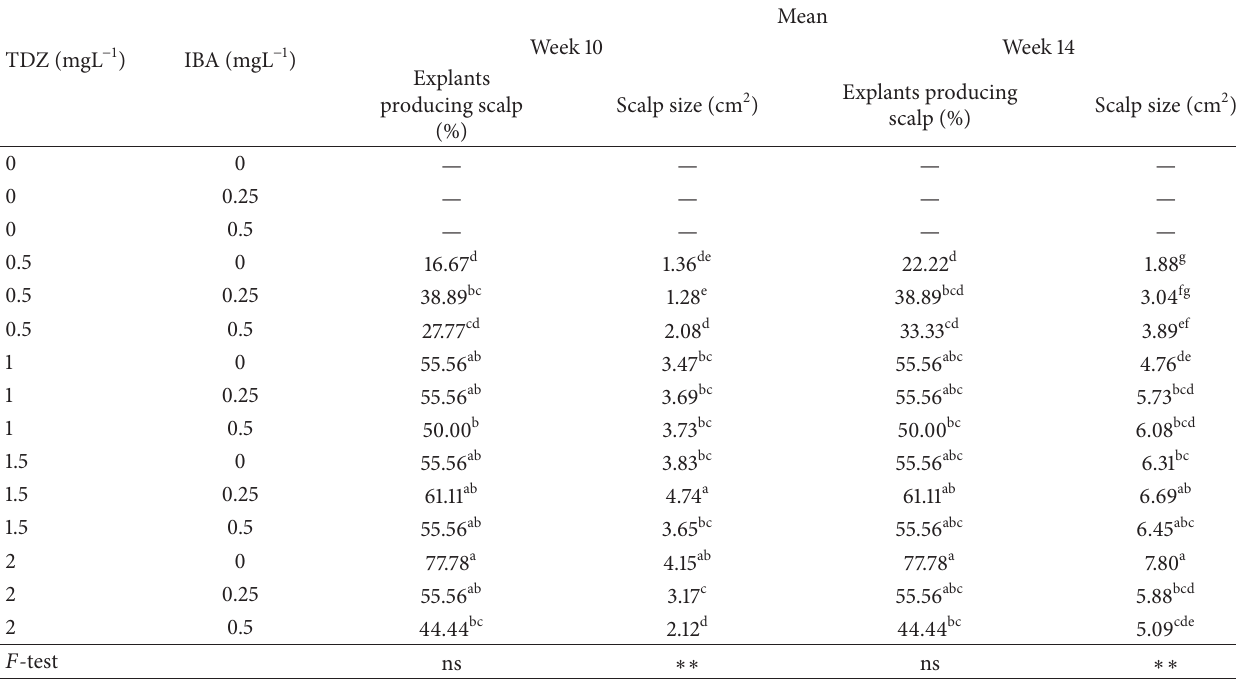
Figure 2: In vitro scalp induction of C. latifolia . (a) scalp induction from shoot tip base on MS medium supplemented with 2 mgL −1 TDZ after 10 weeks; (b) yellowish scalp after segregation from explants and subculturing. Table 2: Effect of different concentration of TDZ and IBA on percentage of explants producing scalp and scalp size after 10 and 14 weeks.